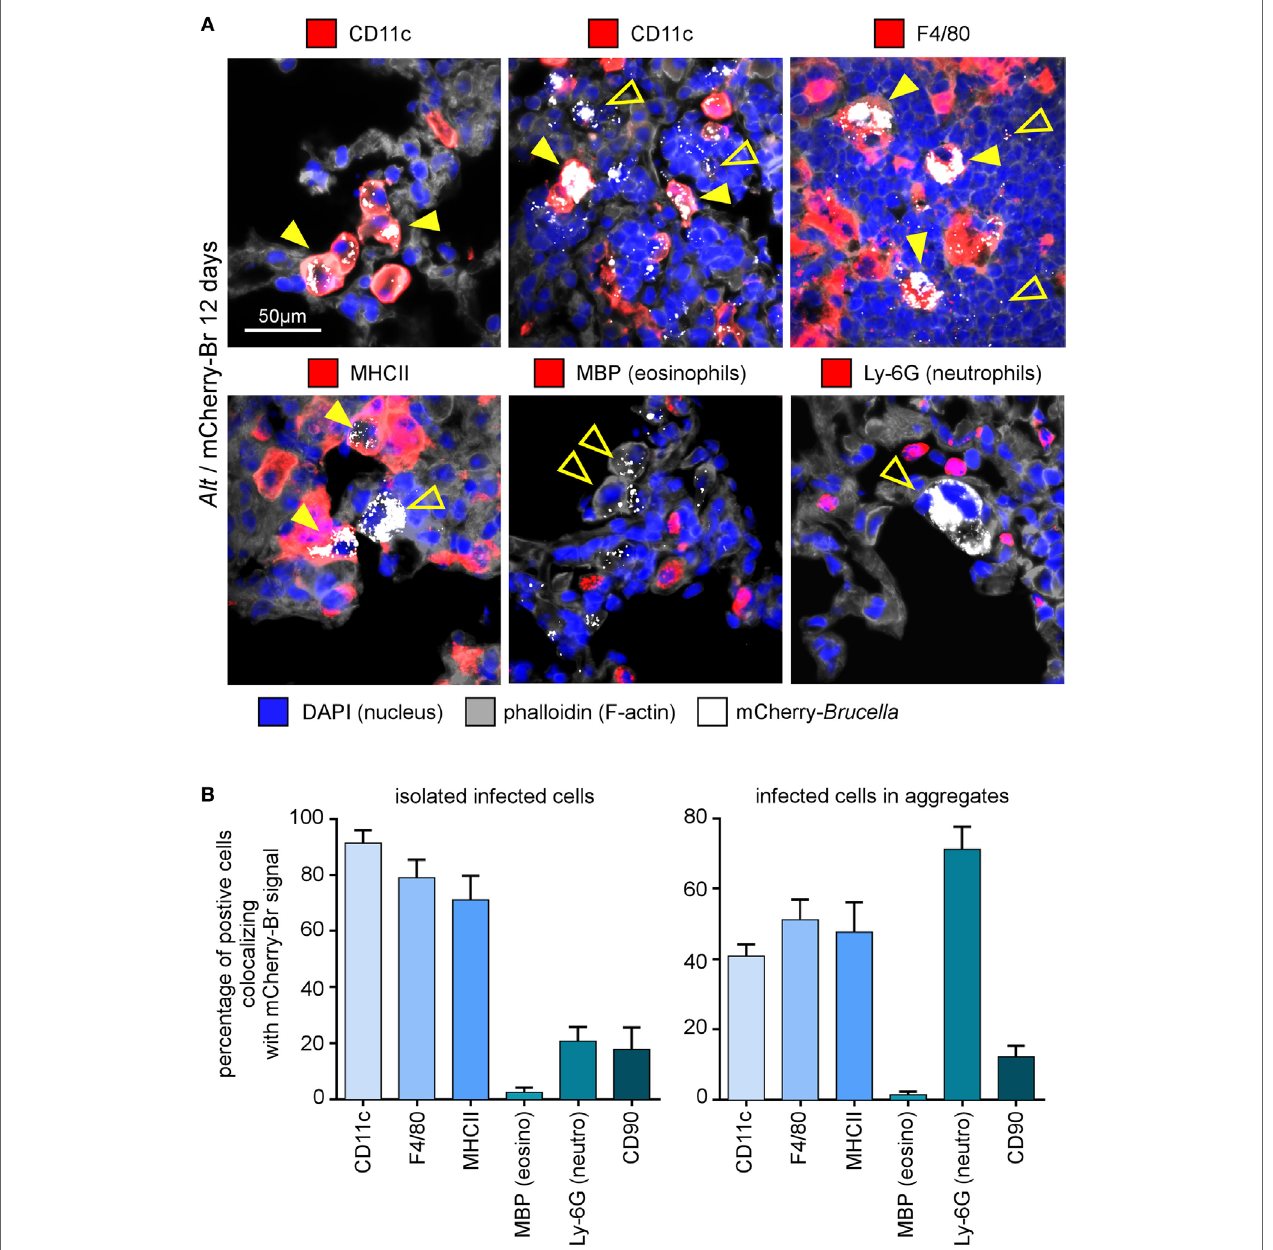
FigUre 3 | Cell surface phenotype of Brucella melitensis infected cells in asthmatic lungs. Wild-type BALB/c mice received repeated i.n. administration of Alt before i.n. infection with 2 × 10 4 CFU of mCherry- B. melitensis . The mice were sacrificed at 12 days post infection. The lungs were harvested and fixed. Frozen sections were examined by immunohistofluorescence for mCherry ( Brucella ), CD11c, F4/80, MHCII, major basic protein (MBP), Ly-6G, and CD90 signals. The panels are color-coded by antigen as indicated. (a) High magnification representative view of infected cells in the lungs. (B) The data represent the percentage of mCherry- Br signal that co-localizes with CD11c, F4/80, MHCII, MBP, Ly-6G, and CD90 markers. When > 12 infected cells are observed in the same observation field (approximately 700 μ m × 500 μ m), they are considered as “aggregated,” and when < 12 are observed, they are considered as “isolated.” At least 200 infected cells from three different infected mice were analyzed for each staining. These data are taken from two independent